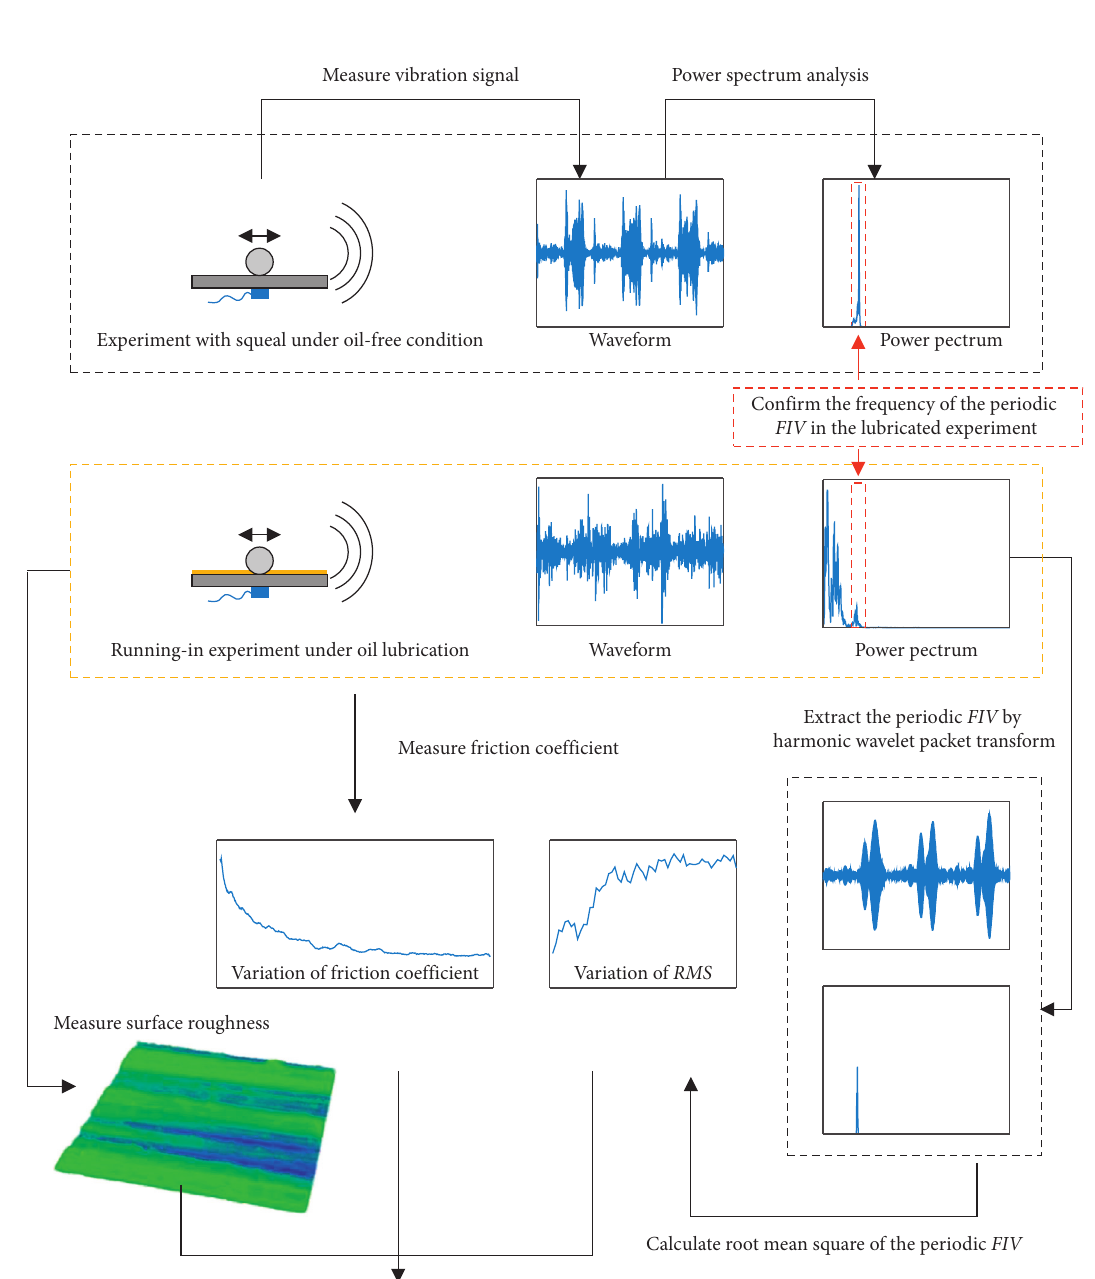
Figure 4: The workflow of the experimental study.